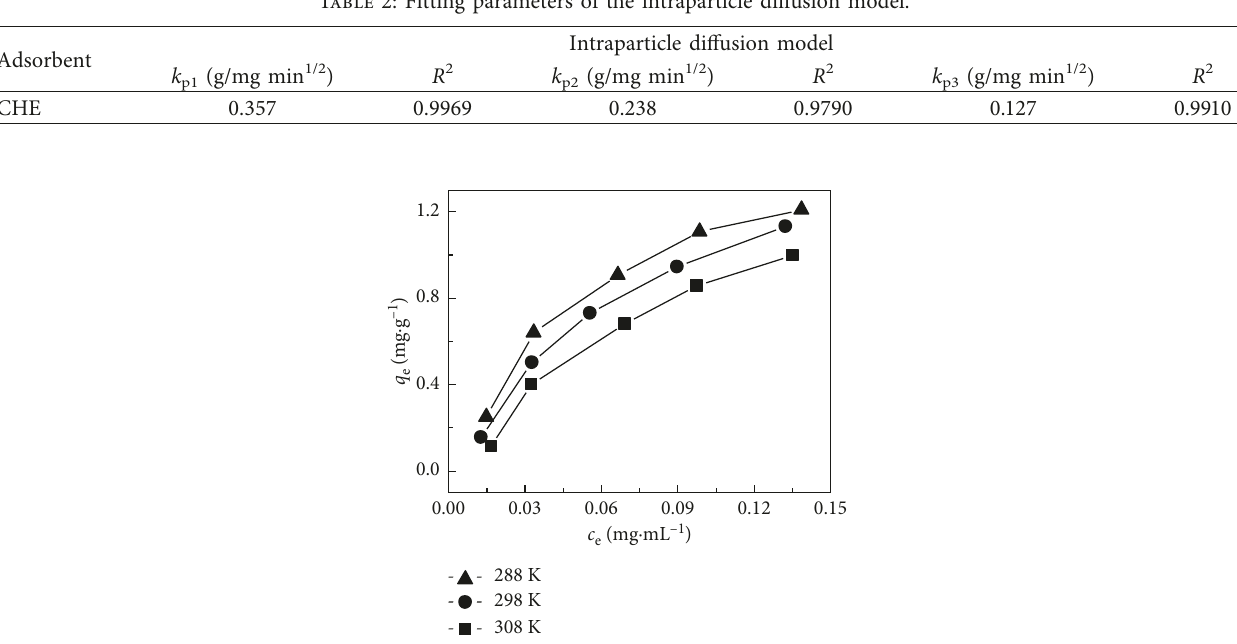
Figure 8: CHE adsorption isotherms of